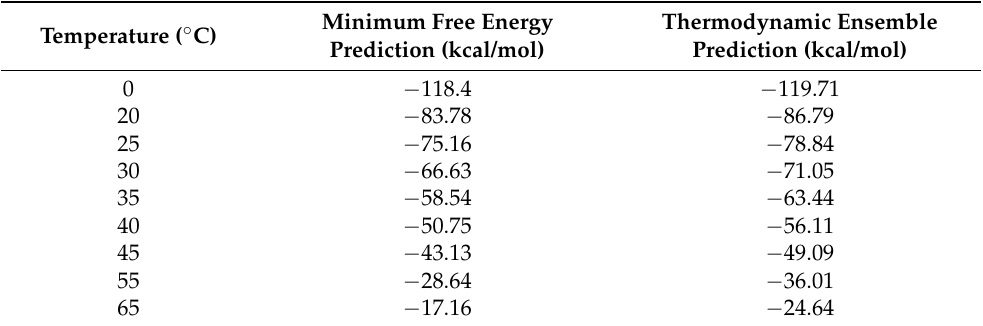
Table 1. Minimum free energy (MFE) 1 of the different secondary structures of ASBVd(-) at different temperatures. Temperature (°C)